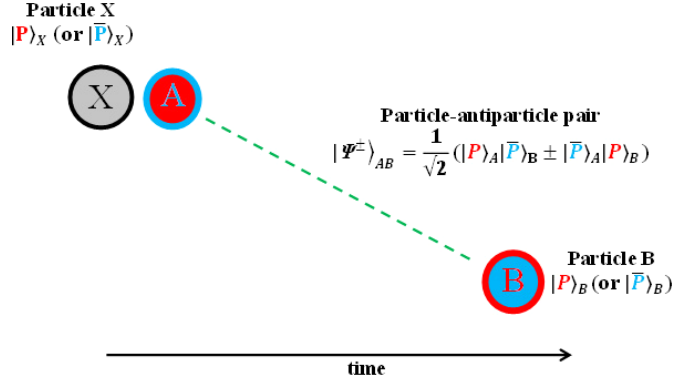
Fig. 2. Schematic diagram for particle – antiparticle teleportation using the packaged entangled states of a particle – antiparticle pair, j (cid:3) (cid:2) i AB ¼ 1 ffiffi ðj P i A j (cid:1) P i B (cid:2) j (cid:1) P i A j P i B Þ , and particle – antiparticle annihilation 2 p phenomenon.